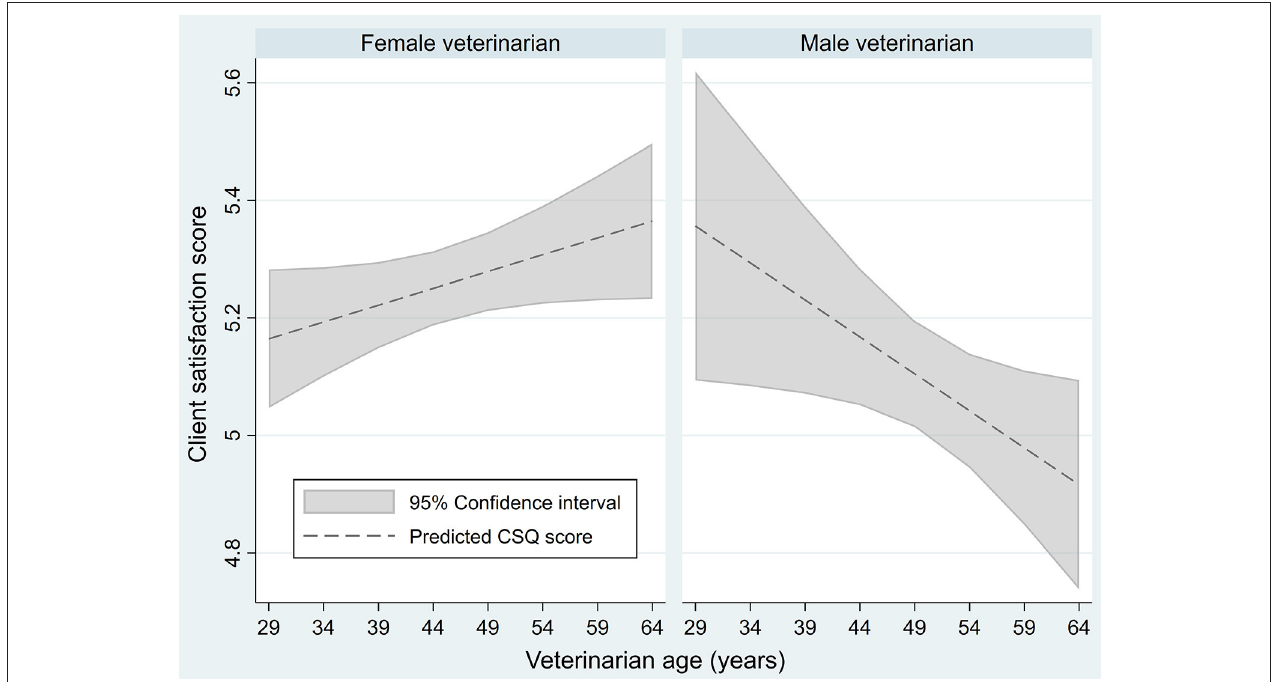
FIGURE 1 | Predicted association between Client Satisfaction Questionnaire scores of veterinary clients ( n = 995) and veterinarian age and gender ( n = 60) in a univariable, multilevel linear regression.